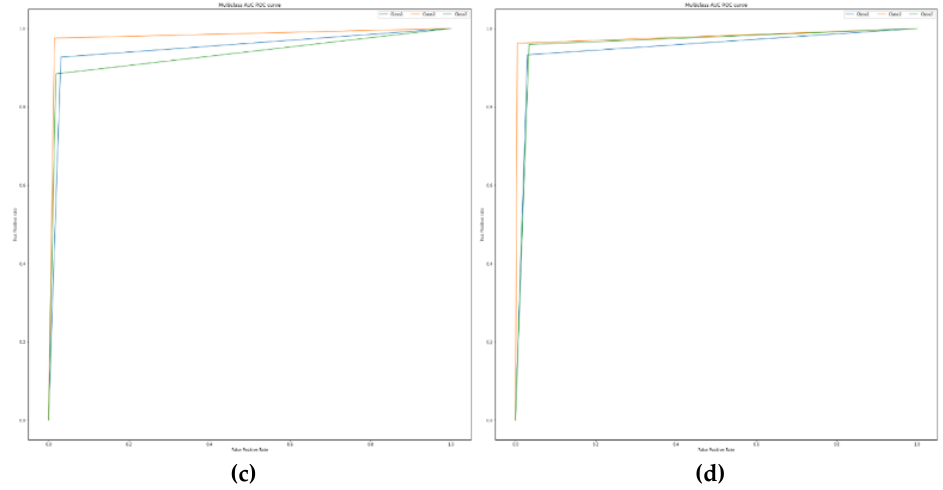
Figure 10. The AUC-ROC curves for the tree-based algorithms, listed as: (a) DT in setting 1; (b) DT in setting 2; (c) RF in setting 1; (d) RF in setting 2.